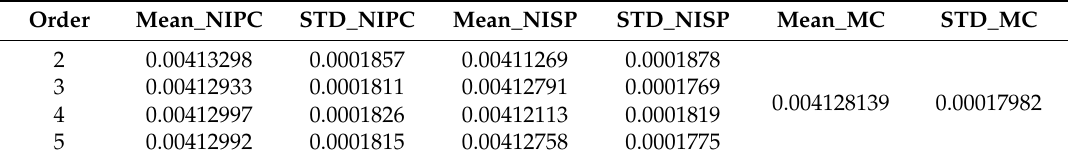
Table 5. The mean and standard deviation of the drag coefficient values for flat plate.